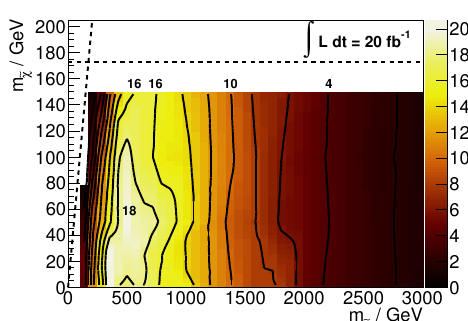
Figure 3 . The minimal value in each model of the (cid:21) 0 coupling for which a sensitivity of 231 f (cid:21) 3 is achieved. Contour lines are drawn at intervals of